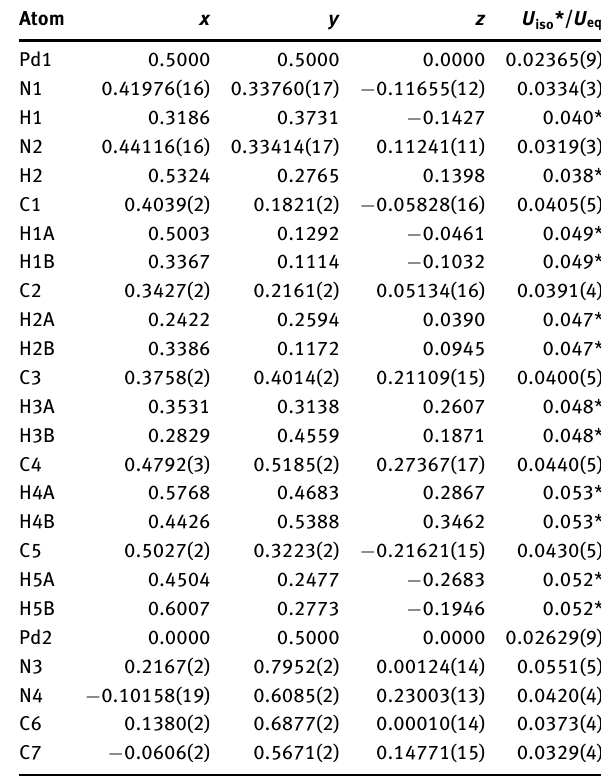
Table 2: Fractional atomic coordinates and isotropic or equivalent isotropic displacement parameters (Å 2